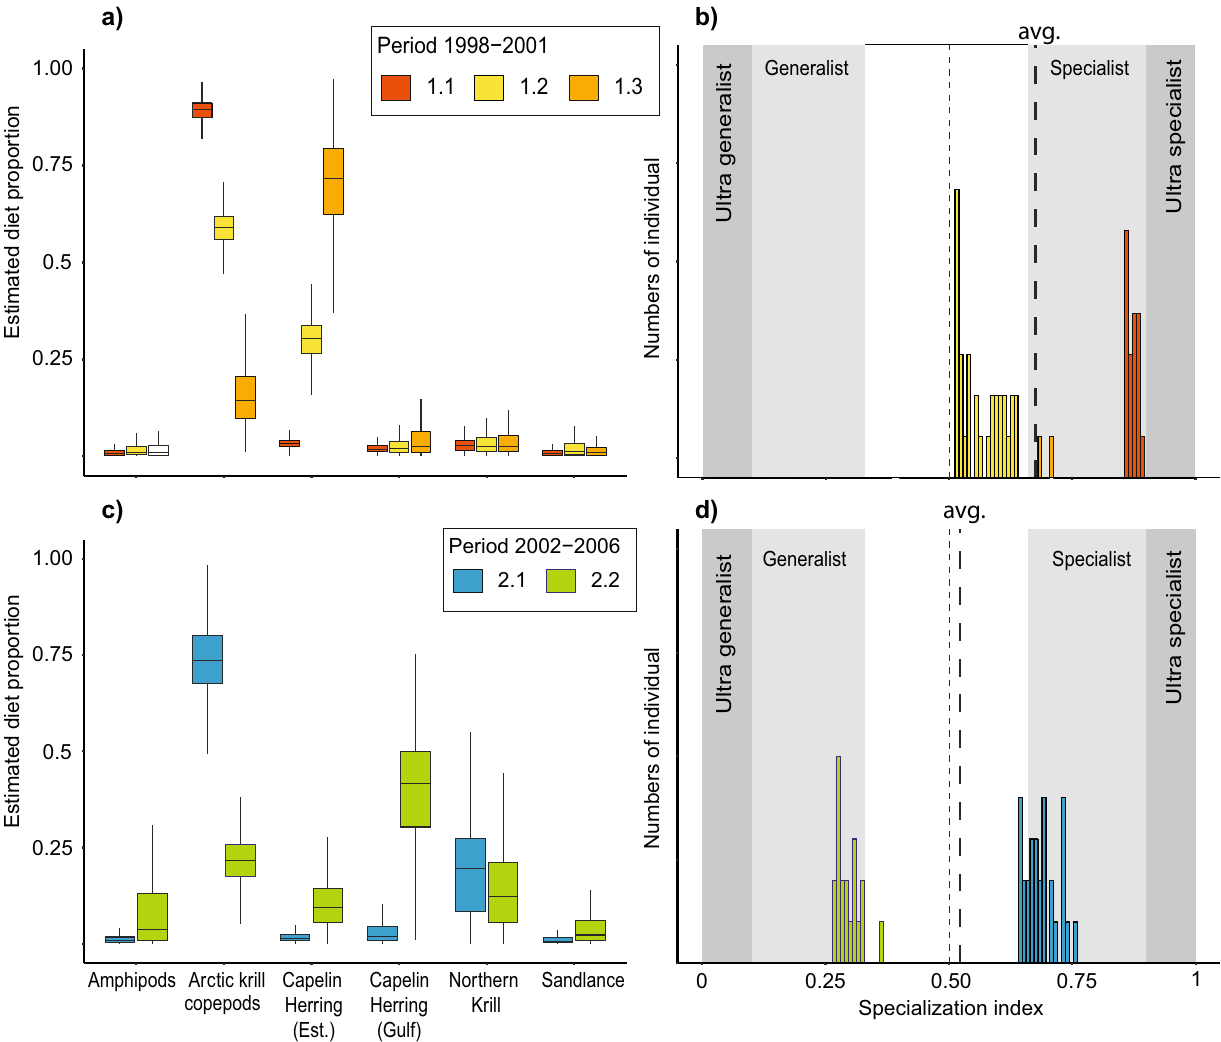
Figure 5. Estimated proportional contributions of potential prey determined from isotopic mixing models (a,c) and specialization index frequency (b,d) for each group of fin whales identified through the hierarchical cluster analysis for the periods 1998–2000 (a,b) and 2002–2006 (c,d)